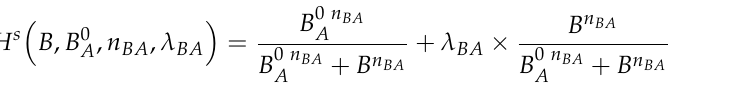
Table 1. Ranges of randomized parameters in RACIPE.